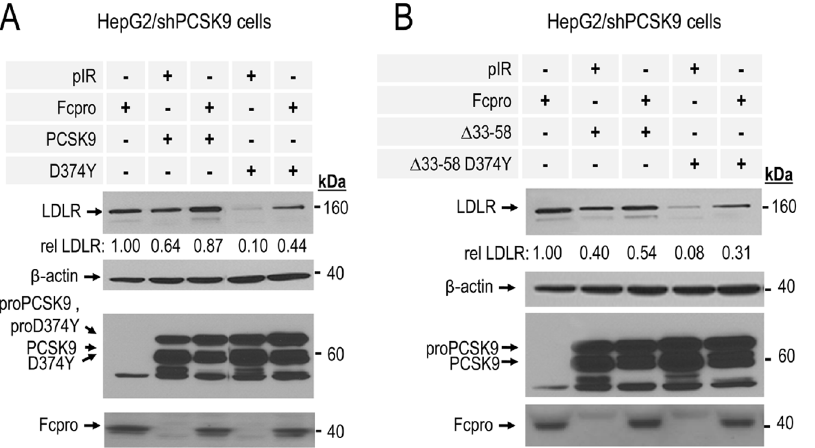
Figure 3. LDLR degradation induced by PCSK9 GOF mutants is decreased by their co-expression with Fcpro. HepG2/shPCSK9 cells were co-transfected with A ) and B ) pIR empty vector as a negative control or PCSK9 prosegment fused to the Fc region chimera (Fcpro) with A ) wild type human PCSK9 or its GOF natural mutant PCSK9 D374Y (D374Y); B ) PCSK9 GOF mutants: prosegment acidic stretch deletant D 33-58 ( D 33-58) or D 33-58 D374Y. Cells lysates were resolved by 10% SDS-PAGE and proteins analyzed by Western blot. Total LDLR was detected using a polyclonal anti- human LDLR and its levels were normalized relative to b -actin cellular loading controls. Fcpro proteins were detected using a polyclonal anti-Fc antibody. PCSK9 or its GOF mutant proteins were detected using a monoclonal anti-V5 antibody. These data are representative of at least three independent experiments.